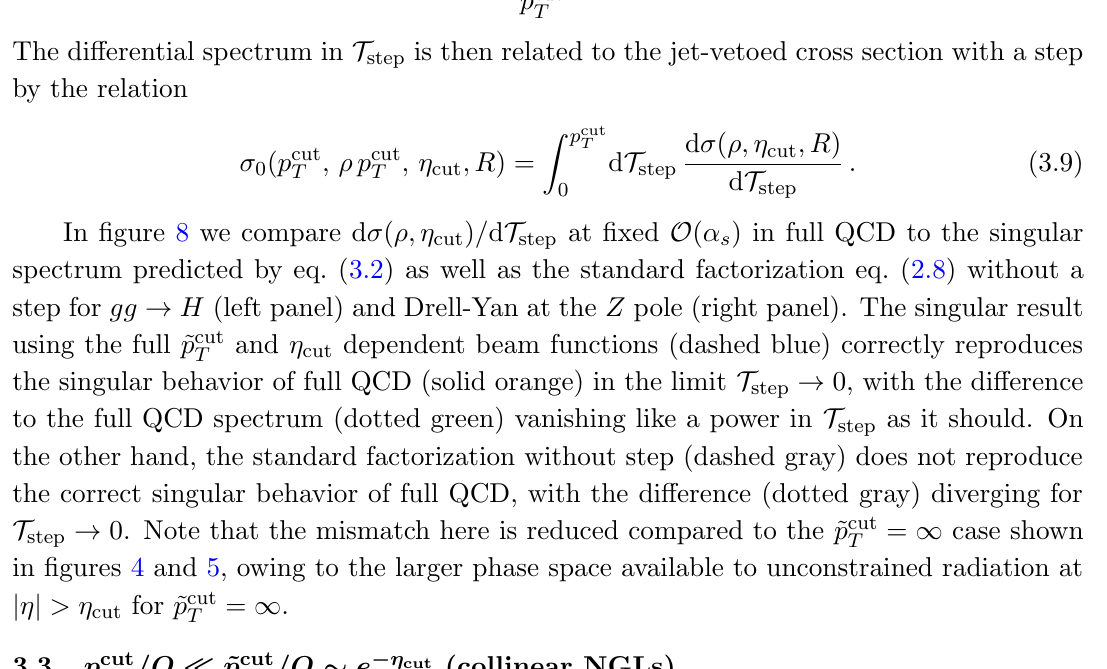
Figure 8 . Comparison of singular and nonsingular contributions to the (cid:12)xed spectrum with a step at (cid:17) cut = 2 : 5 and (cid:26) = ~ p cut Q = m Z (right). The orange solid lines show the full results, the dashed blue lines the singular result that accounts for the jet veto step at (cid:17) cut in the beam function, and the dotted green lines their di(cid:11)erence. The dashed and dotted gray lines show the corresponding results without taking into account the step in the jet veto, which do not describe the singular behavior of the full cross